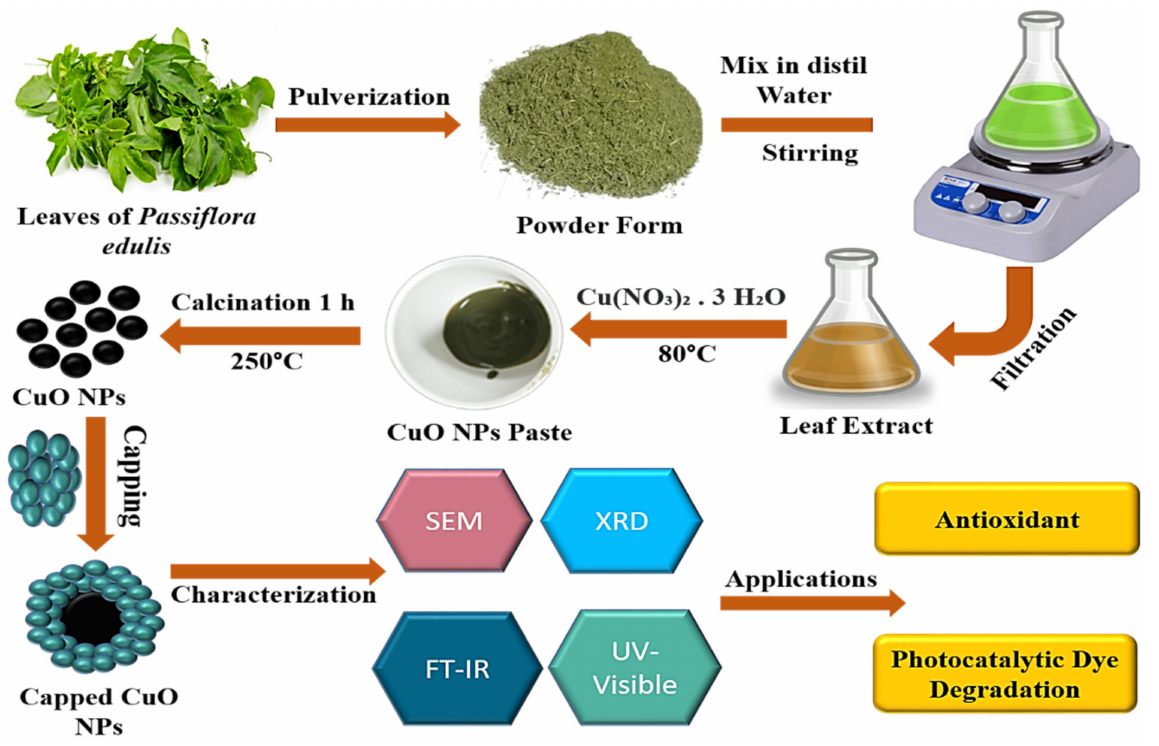
Figure 1. Copper oxide nanoparticle green